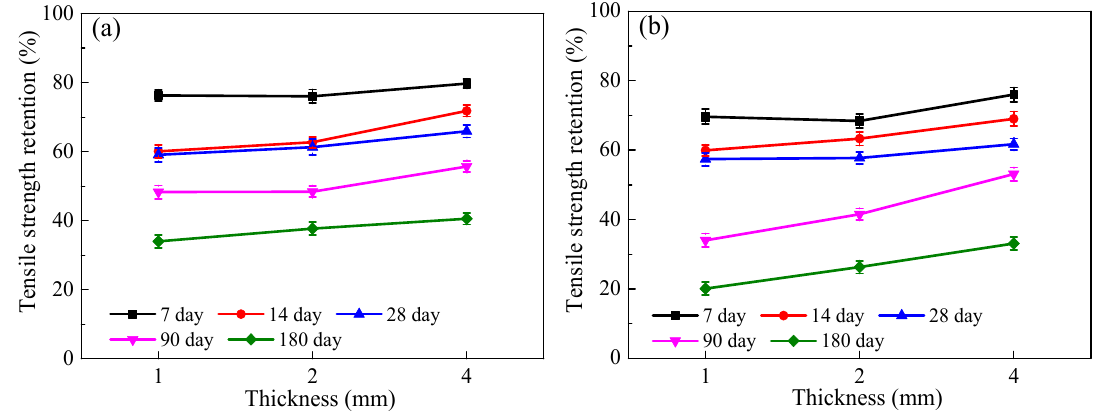
Figure 11. Variation of tensile strength retention vs. specimen thickness soaked in ( a ) deionized water and ( b ) alkaline solution at different ageing days.